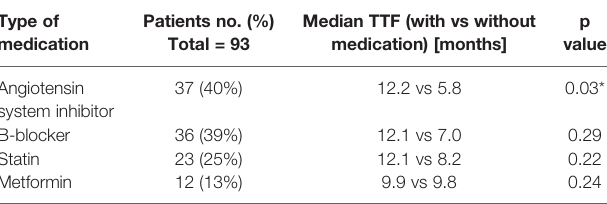
TABLE 3 | Type of concomitant medications and their in fl uence on TTF (univariate